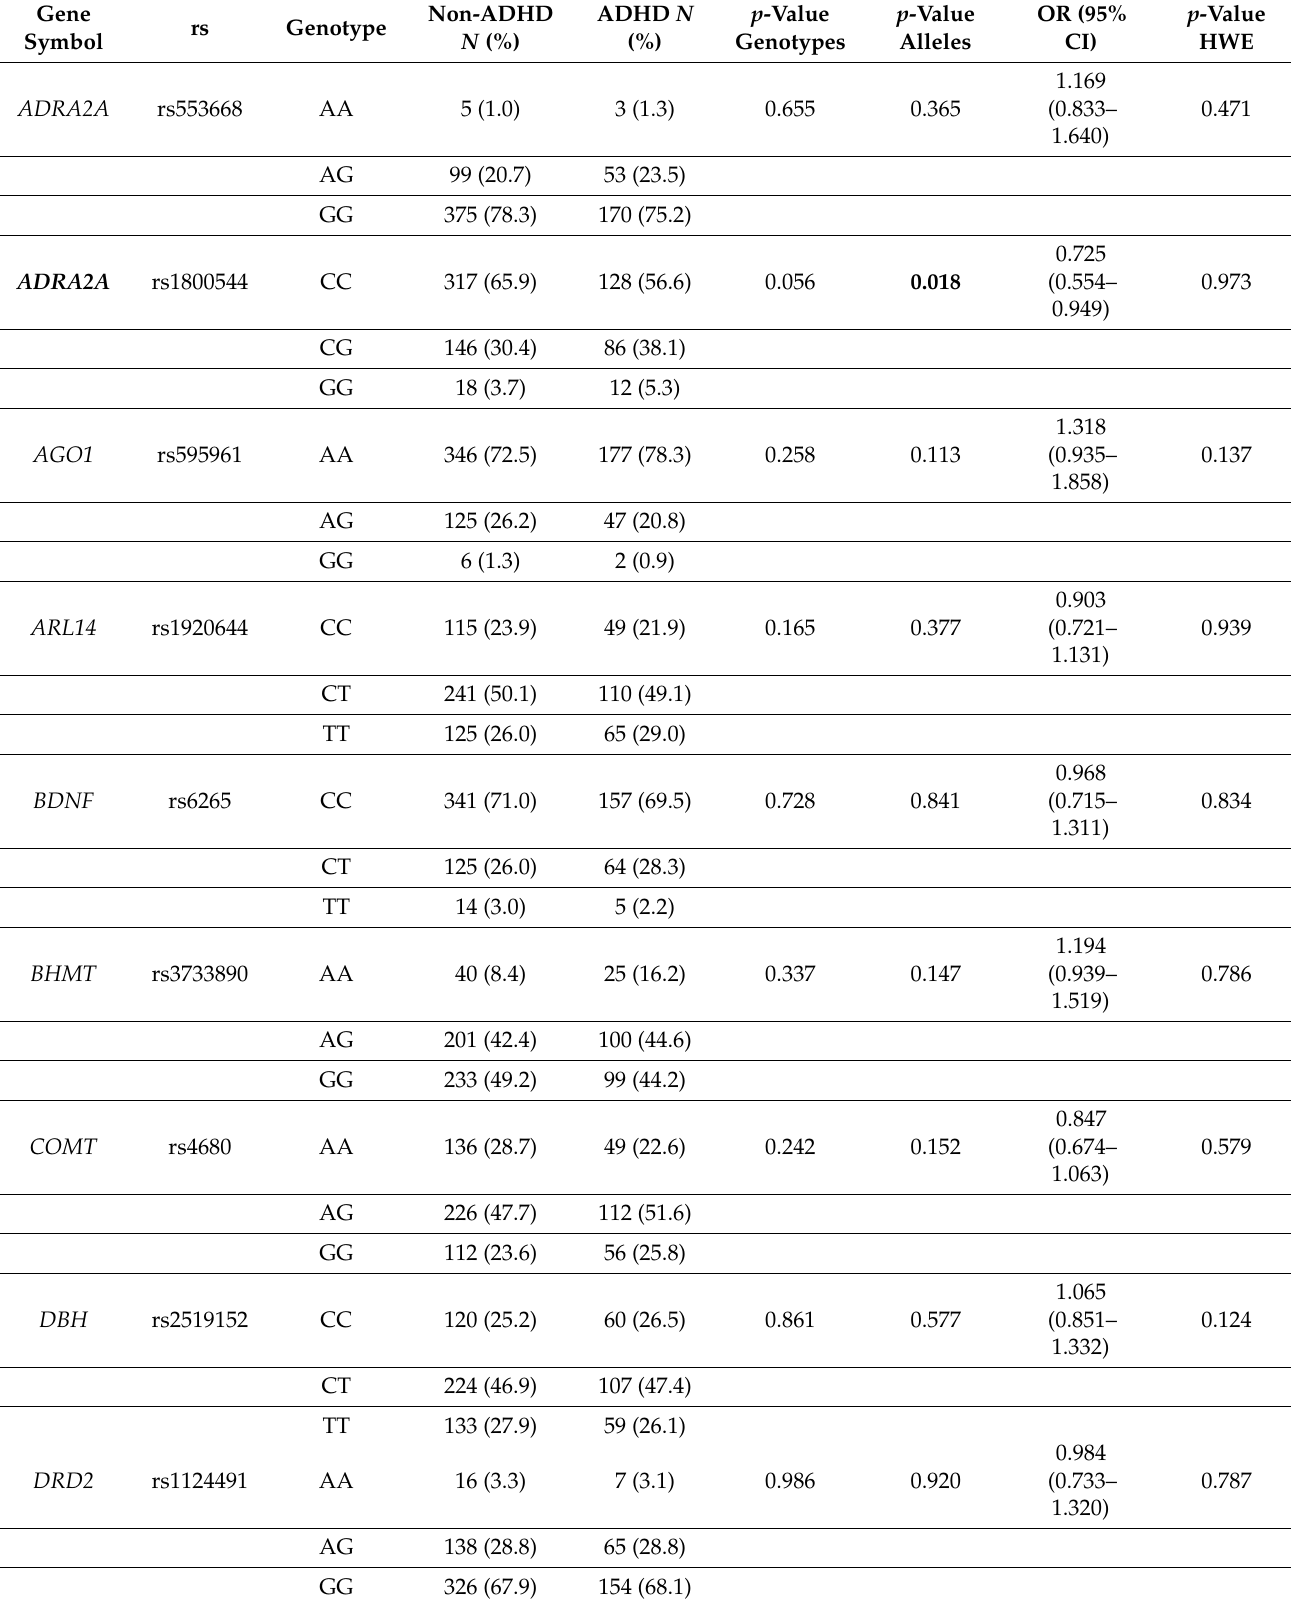
Table 3. Genotype and allele frequencies in ADHD and non-ADHD